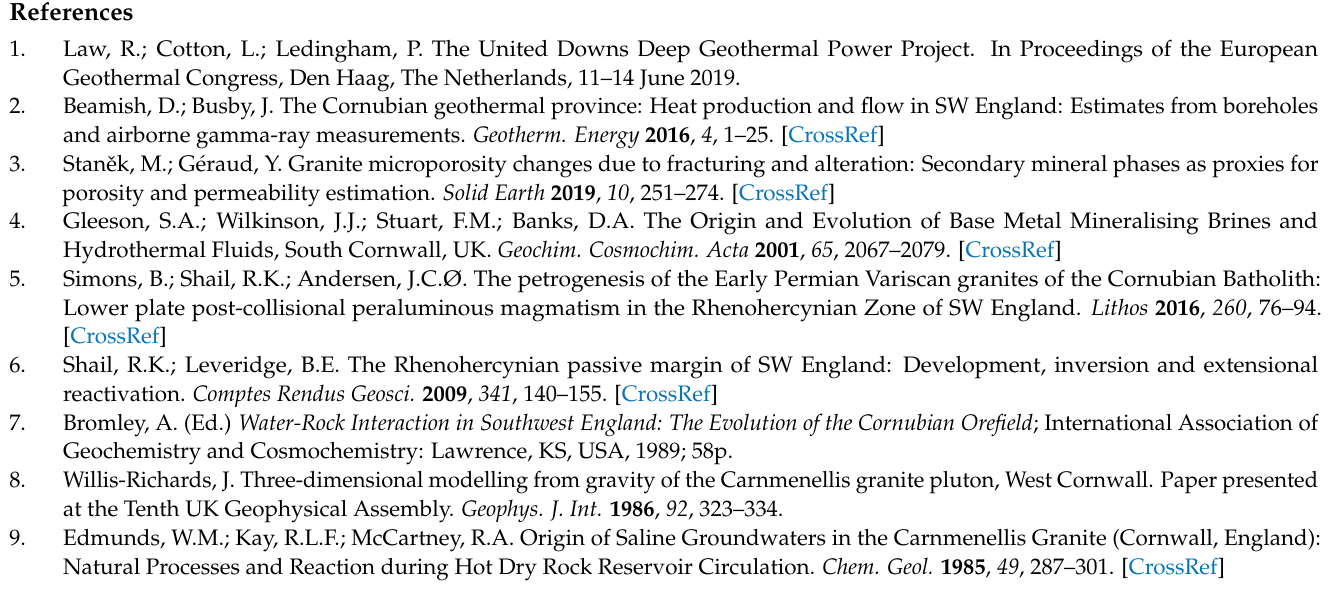
Figure A1. Comparison of the relative mineralogical composition before and after chemical treatment in AEs and CFTs.